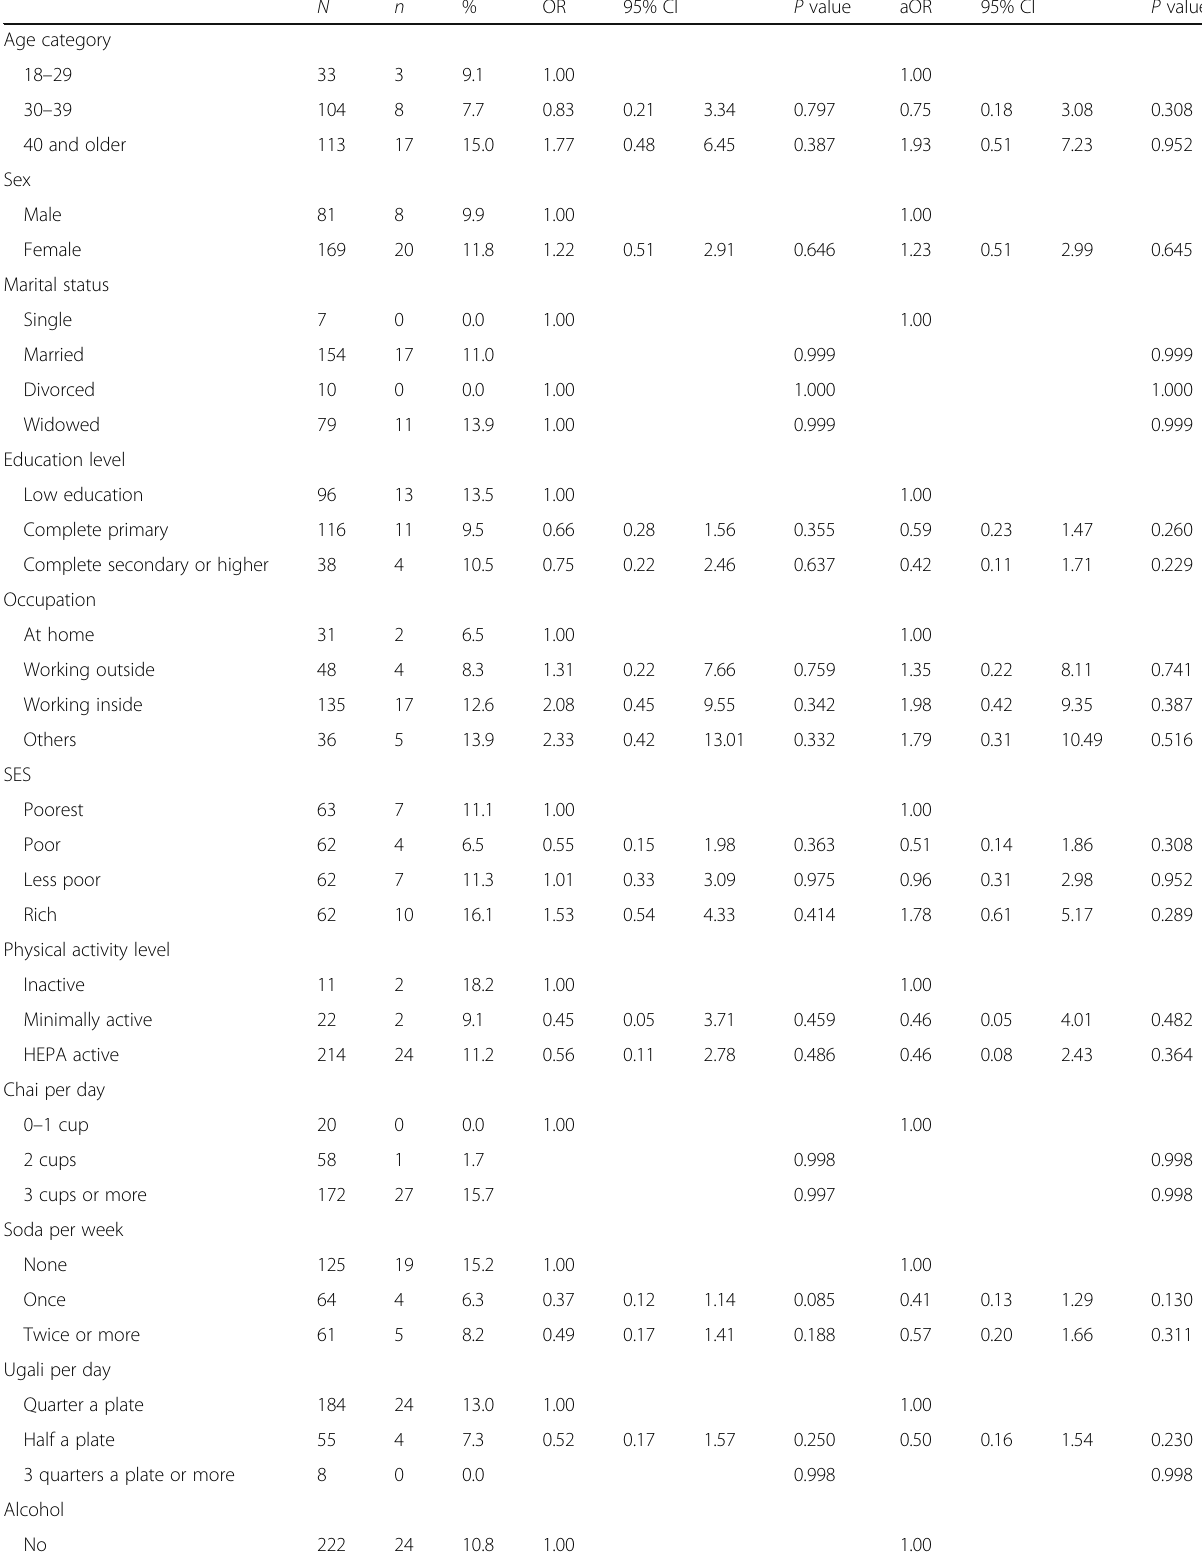
Table 5 Factors associated with